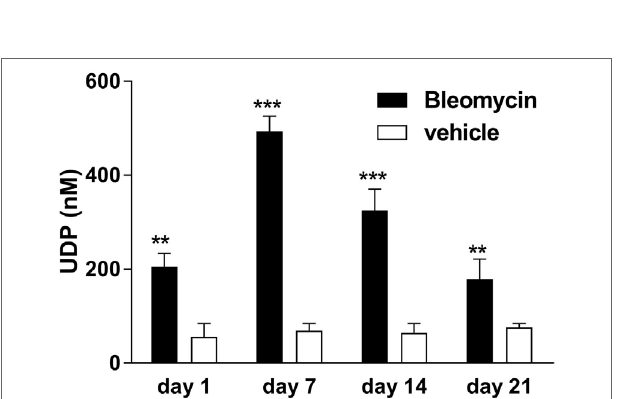
FigUre 3 | Elevated extracellular uridine-5 ′ -diphosphate (UDP) levels in bleomycin-induced pulmonary fibrosis. Male C57Bl/6 mice received an i.t. injection of BLM or vehicle on day 0. Animals were killed at the indicated time points, and UDP levels were measured in the bronchoalveolar lavage fluid ( n = 4–6 per group) (** p < 0.01; *** p <